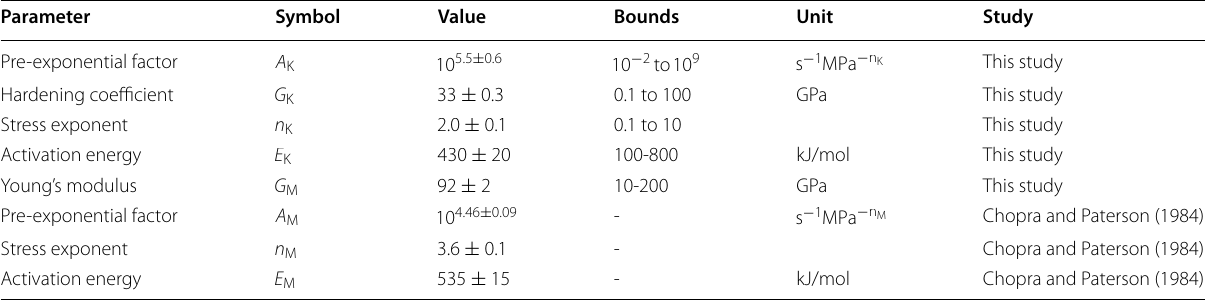
Table 4 Flow law parameters of dry dunites determined from the constant-strain rate experimental data. The bounds column contains the lower and upper bounds used for Gibbs sampling. Steady-state parameters for dunites are from Chopra and Paterson (1984). The errors are for one standard